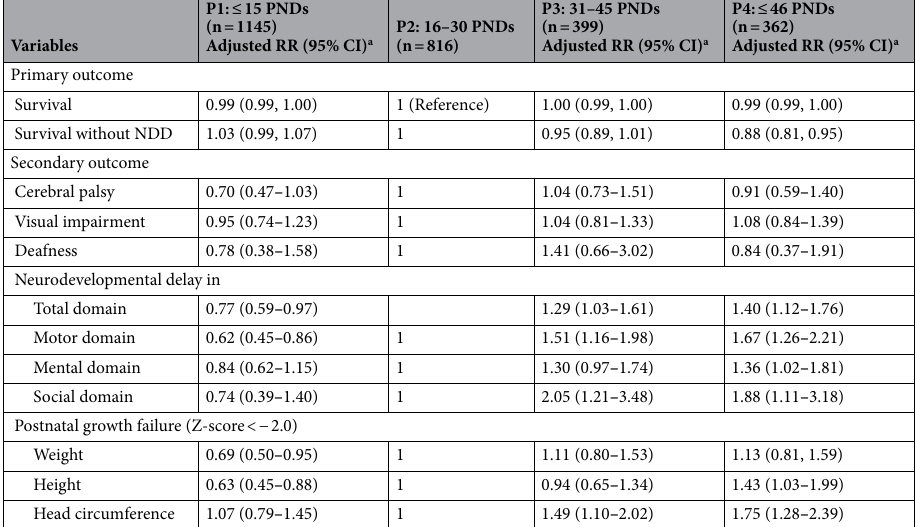
Table 1. Adjusted relative risk for neurodevelopmental and growth outcomes at 18–24 months’ corrected age. Abbreviations: PND, postnatal day; RR, relative risk; CI, confidence interval; NDD, neurodevelopmental delay. a Adjusted for gestational age, Apgar score at five min, small for gestational age, antenatal steroid use, and presence of pregnancy-induced hypertension, intraventricular hemorrhage (≥ grade 3), total sepsis, periventricular leukomalacia, bronchopulmonary dysplasia (≥ moderate), necrotizing enterocolitis (≥ 2b), and retinopathy of prematurity requiring laser